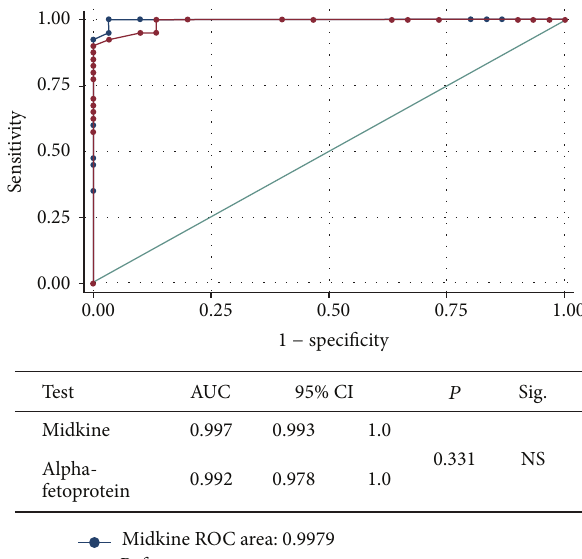
Figure 3: ROC curve showing comparison of the diagnostic performance of serum MDK and AFP for discriminating HCC group from healthy group.